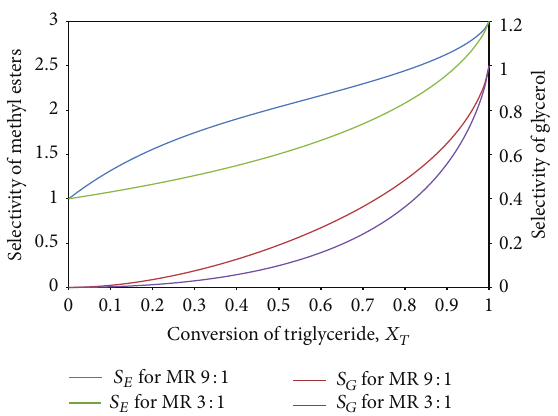
Figure 7: Selectivity plots: (a) methyl ester 1, (b) methyl ester 2, and (c) methyl ester 3 for dataset